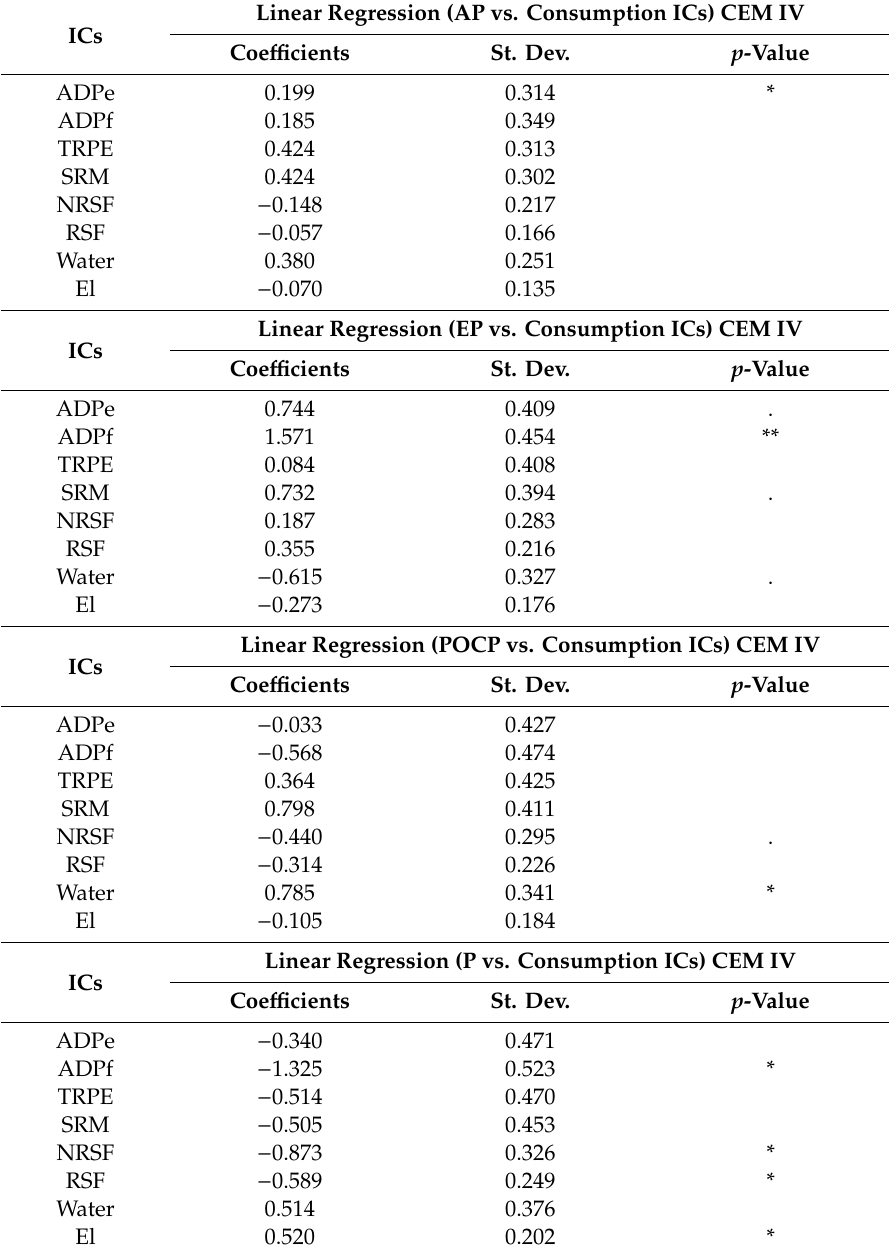
Table 18. Linear regression summary—CEM